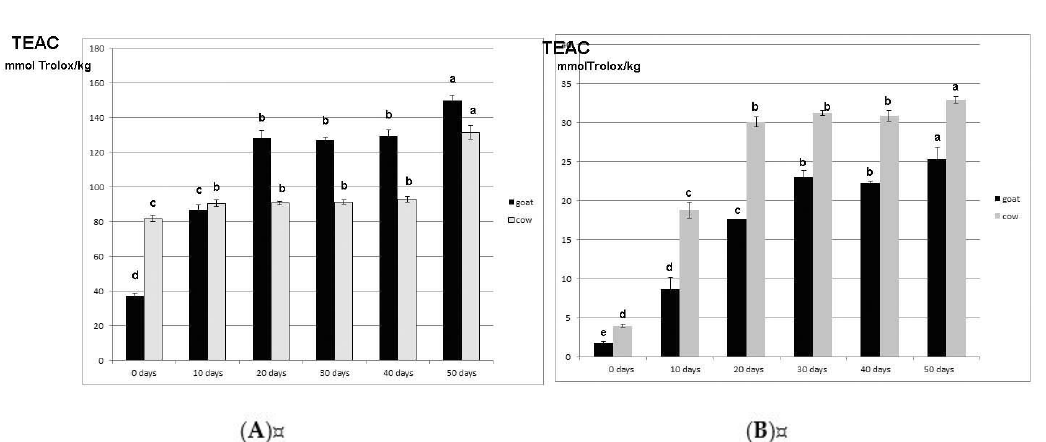
Figure 2. The change of total antioxidant capacity (TEAC) of water-soluble ( A ) and water-insoluble protein fractions ( B ) during the proteolysis of white-brined cheeses prepared from enzymatically pretreated and overheated goat and cow’s milk. Values with the same letters within the same graph are not statistically significant at p <